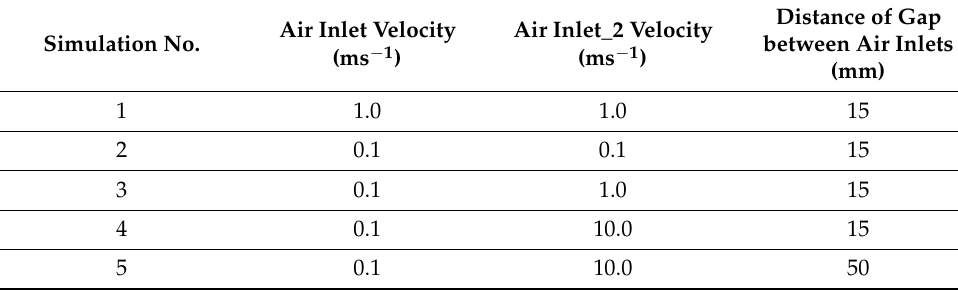
Table 6. Boundary conditions of each